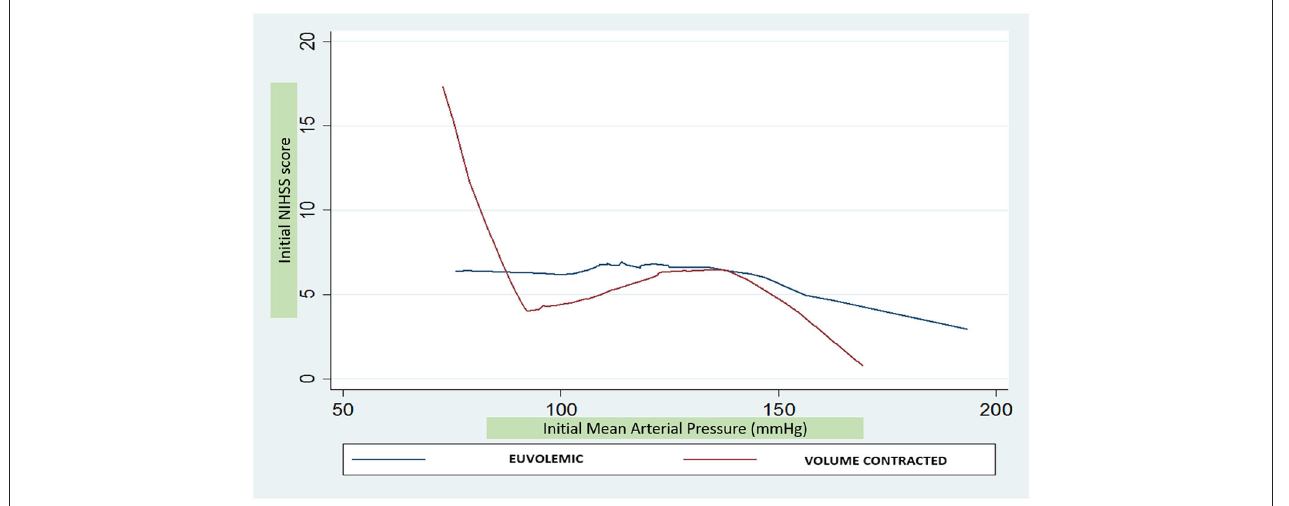
FIGURE 1 | Comparison of NIH stroke scale score and mean arterial pressure by hydration